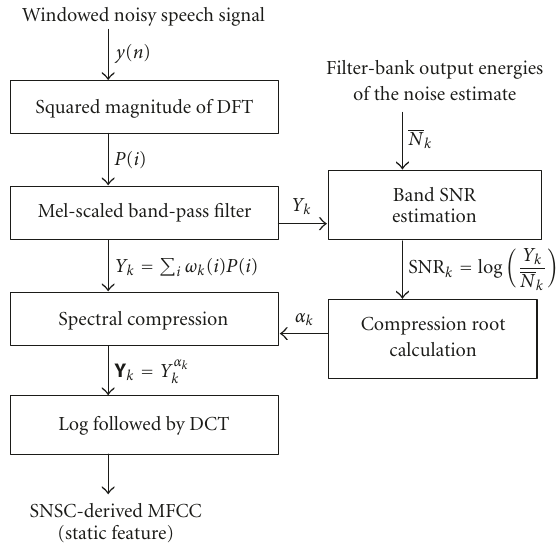
Figure 1: Procedure of the SNSC